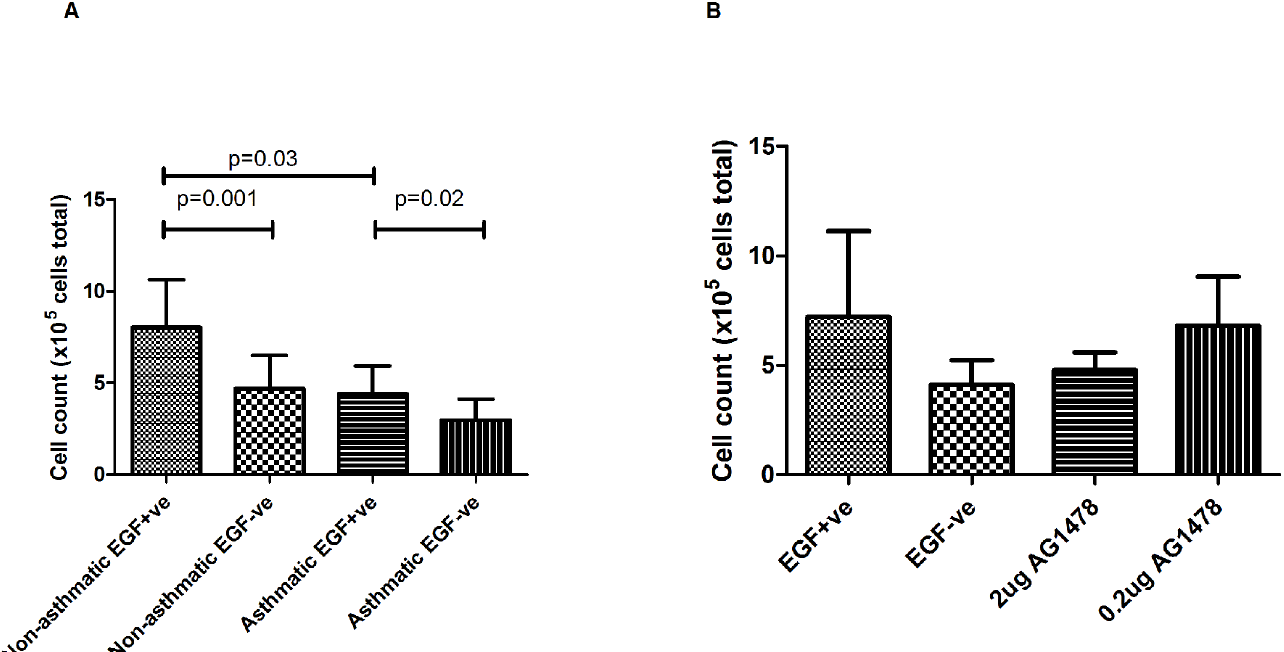
Fig 2. Total Cell Count. Total cell count (x10 5 ) on day 28 of ALI culture. (A) Asthmatic and non-asthmatic cultures in the presence or absence of EGF (10ng/ml) (n = 5). Data analysed using a 2-way repeated measures ANOVA with planned unadjusted t-tests. (B) Asthmatic cultures in the presence or absence of EGF +/- AG1478 (0.2 or 2 μ g/ml) (n = 4). Data analysed using a 1-way repeated measures ANOVA. Values are expressed as mean